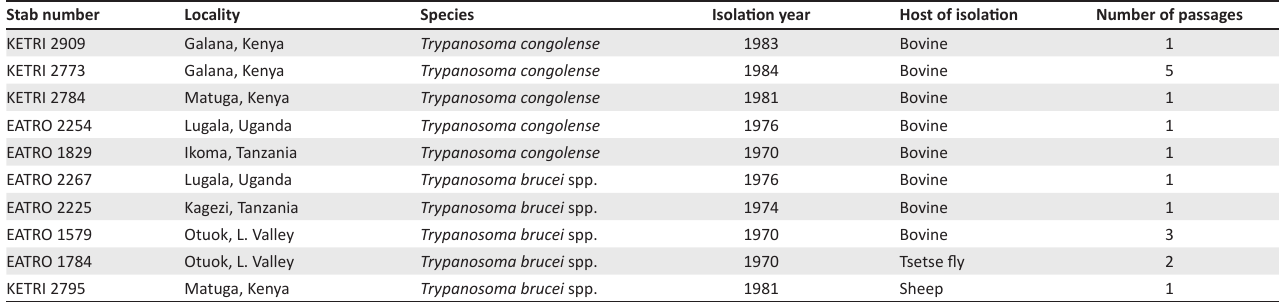
TABLE 1: Trypanosome species, locality, host and year of isolation. Stab number